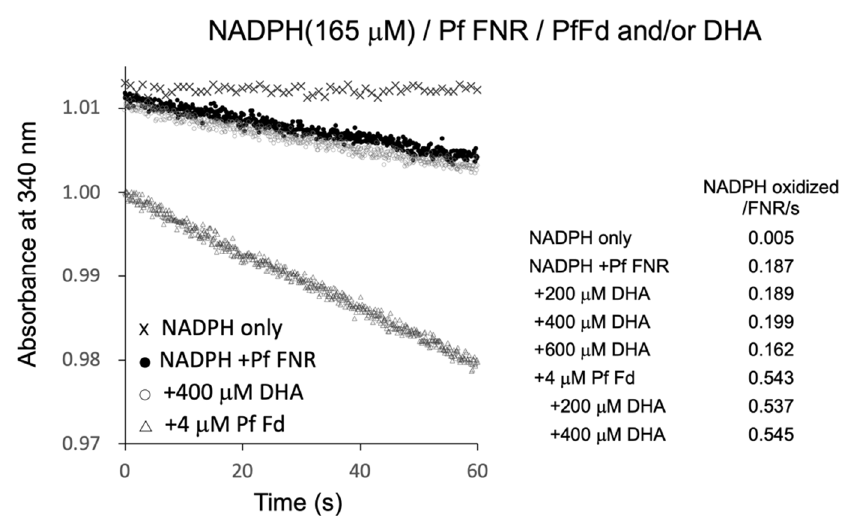
Figure 4. NADPH oxidation by PfFNR (closed circles), PfFNR plus DHA (open circles), and/or PfFd (triangles). The activity was measured under 165 µM NADPH with different concentrations of DHA in the absence and presence of Fd at 4 µM. Absorption at 340 mm was monitored at 0.1 s intervals except for the measurement of ‘NADPH only‘ at 1 s intervals.